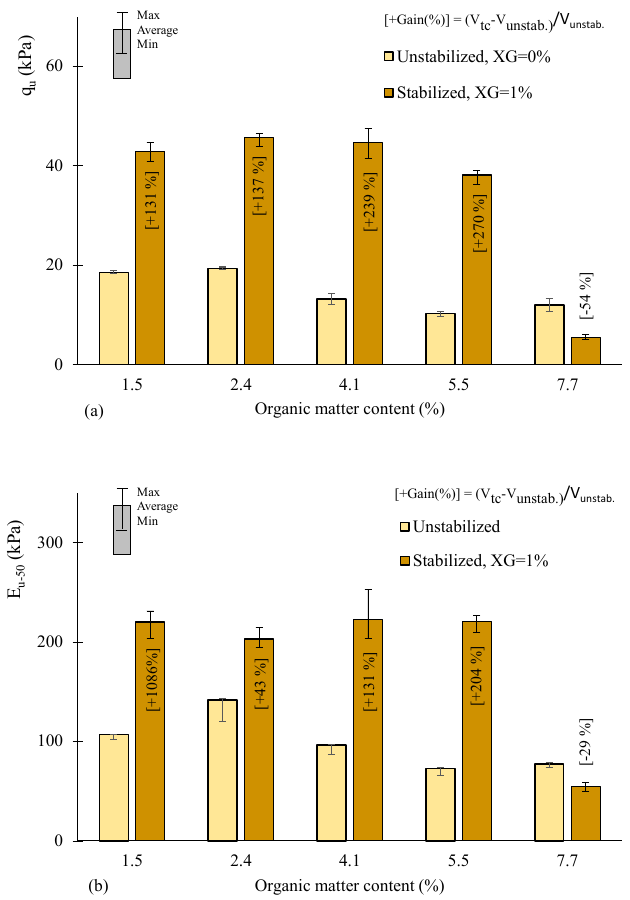
Figure 4. UCS tests. Effect of OM on the evolution of: ( a ) q u ; ( b ) E u-50 . The evolution of the secant modulus at 0.5q u (E u50 ) with the OM content (Figure 4b) matches with the trend observed in Figure 4a for qu. In fact, the stabilization with XG range of 1.5–5.5%, while for an OM content of 7.7% a reduction of 29% was